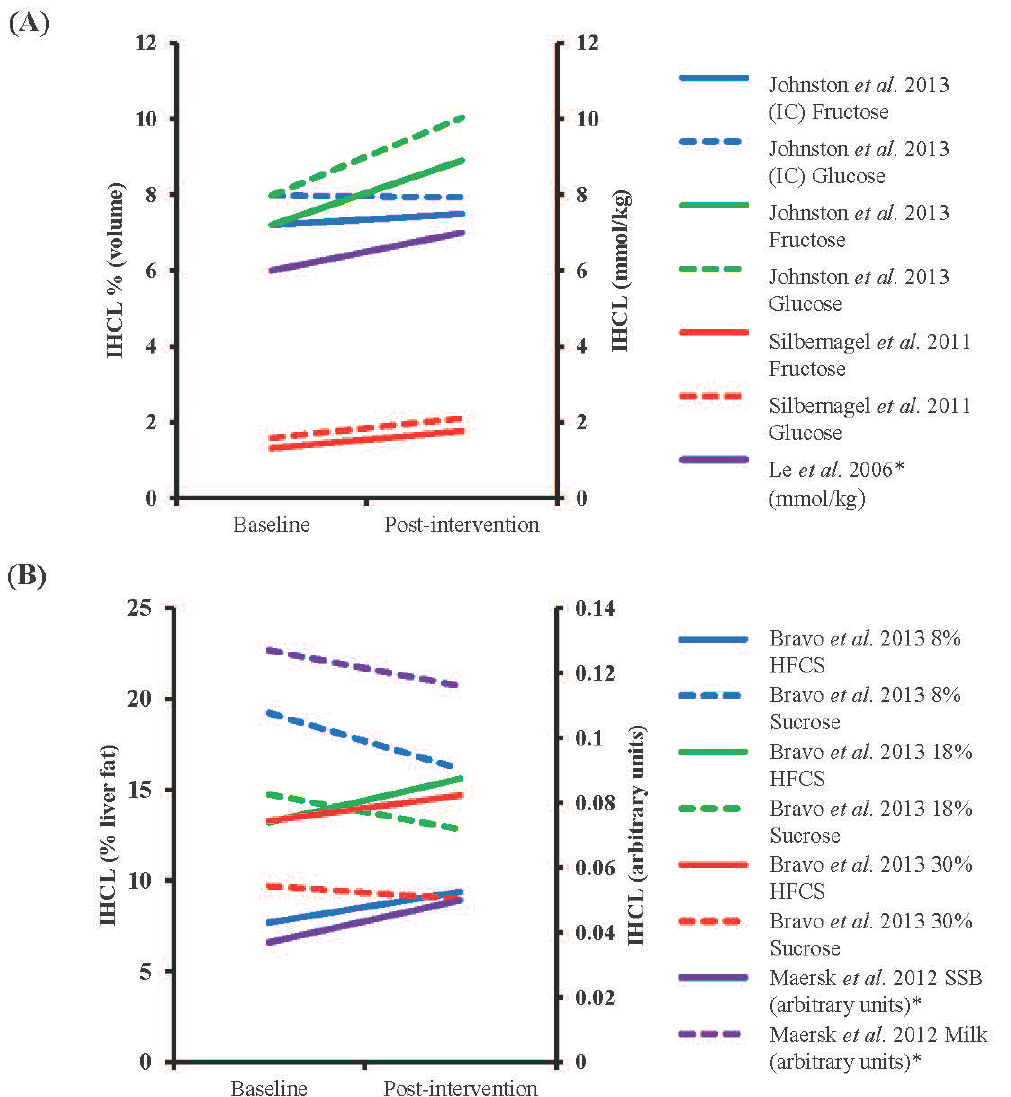
Figure 2. The effect of isocaloric (IC) and hypercaloric monosaccharide feeding on IHCL over more than seven days. ( A ) Changes in interventions using fructose and/or glucose.